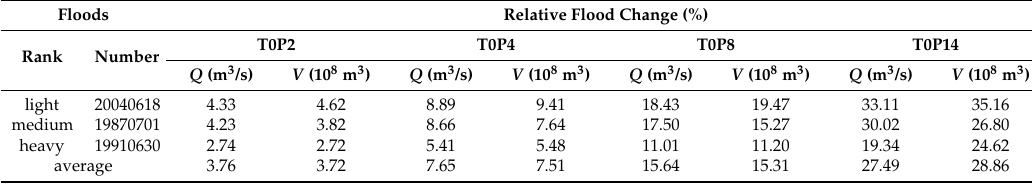
Table A2. Relative flood change under different precipitation